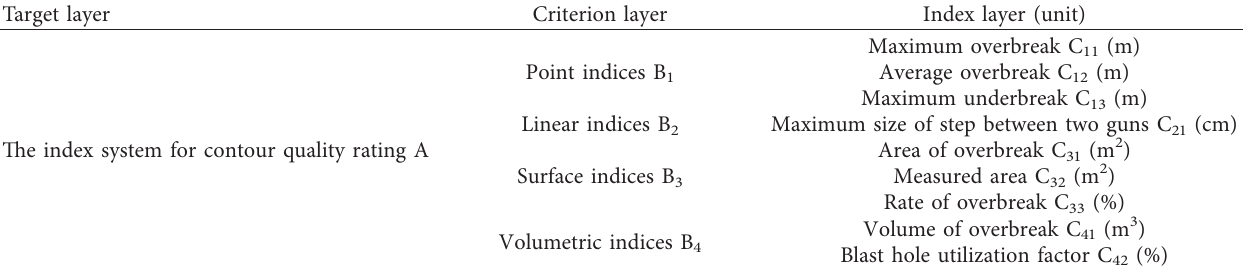
Table 11: Developed multiple indices